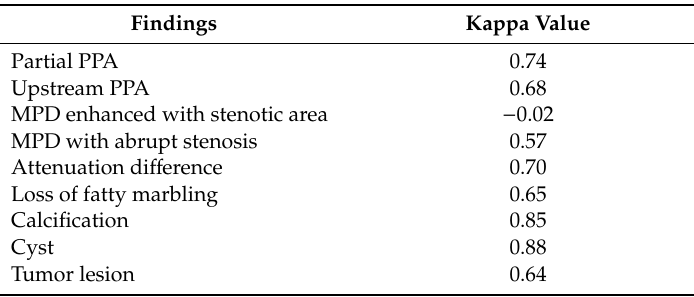
Table 2. Kappa values for the two